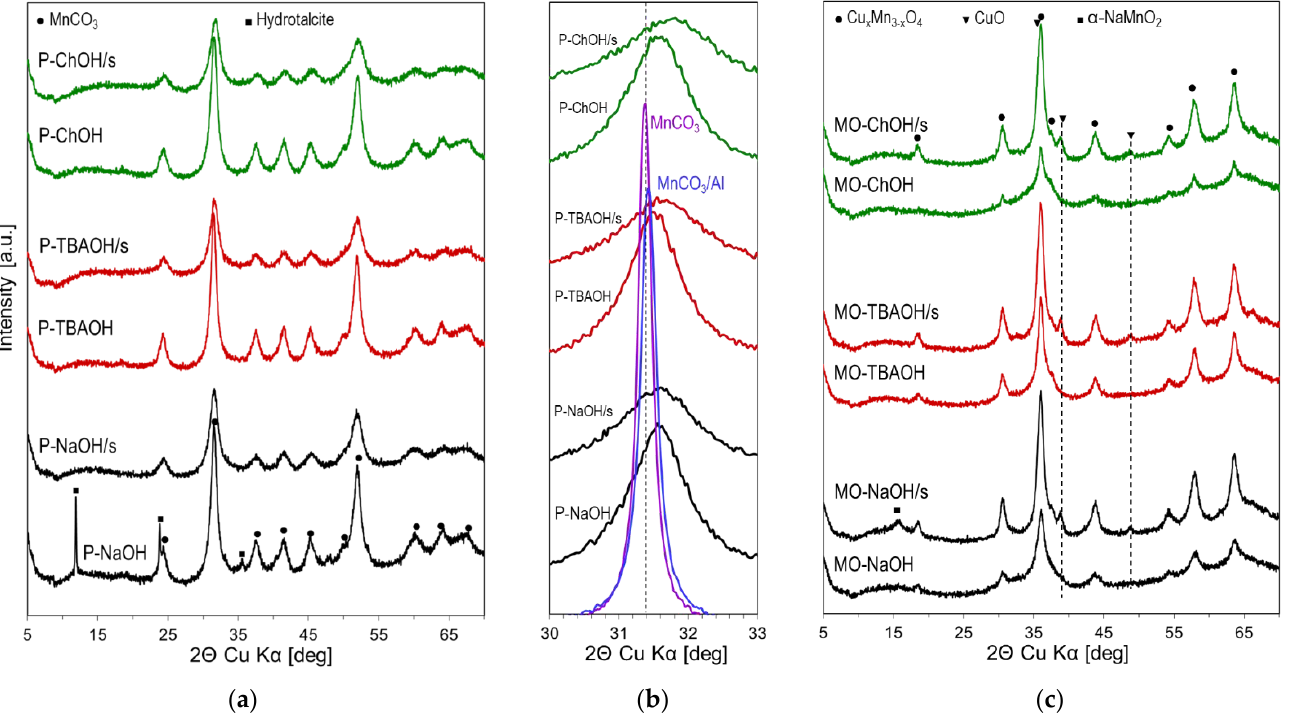
Figure 1. XRD patterns of: ( a ) precursors of mixed-oxide catalysts; ( b ) close-up of (104) reflection in, as received precursors, pristine MnCO 3 and MnCO 3 /Al (rhodochrosite phase obtained from mixed Mn–Al salt solution); ( c ) mixed oxides obtained by the calcination of precursors at 450 ◦ C. The XRD patterns of precursors calcined at 450 ◦ C are gathered in Figure 1c. All with a structure best fitted to that of the Cu 1.5 Mn 1.5 O 4 formula (Ref. code 70-0260).